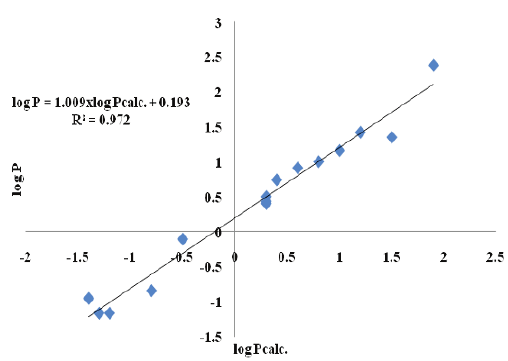
Figure 4. The plot of Log P vs. log Pcalc. by similarity